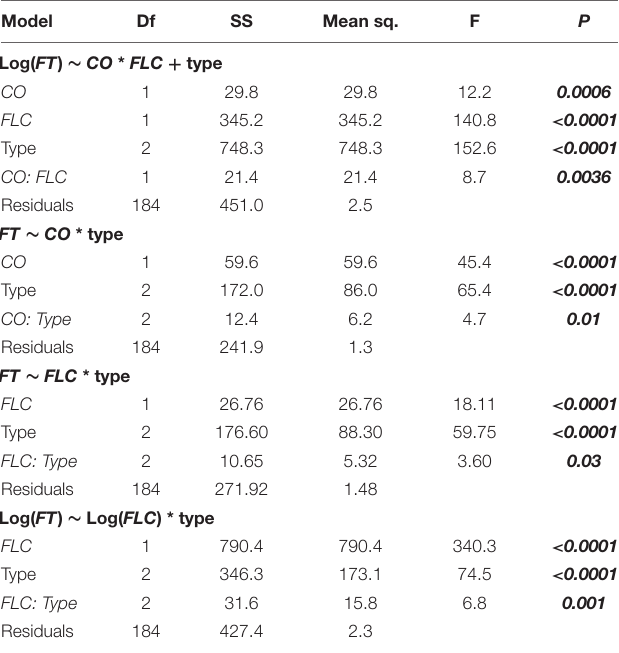
TABLE 2 | Results of analysis of variance (ANOVA) for FLOWERING LOCUS T ( FT ) relative to CONSTANS ( CO ), FLOWERING LOCUS C ( FLC ), and flowering type. Model Df SS Mean